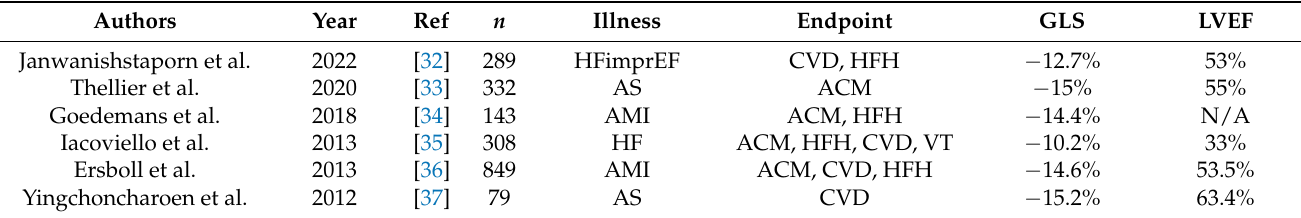
Table 1. Speckle-tracking echocardiography studies in evaluating LV